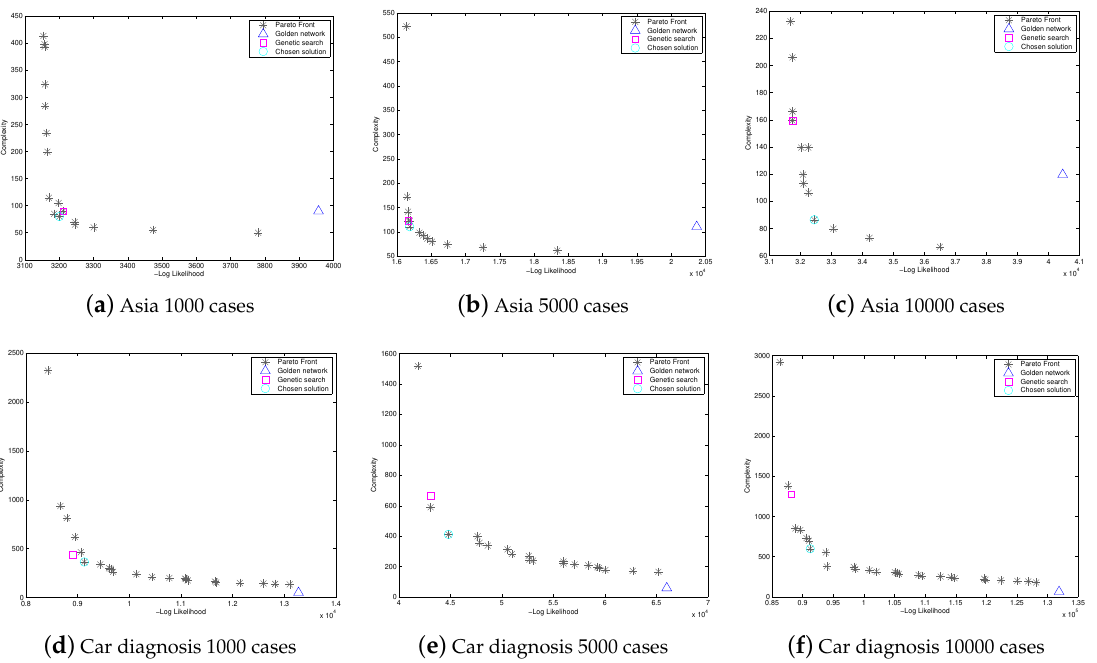
Figure 6. Accumulated Pareto front of the well-known benchmark databases with the different number of cases. Gray stars—the accumulated front obtained by ten runs of NS2BN. Blue triangle—the golden- standard network. Pink square—the GABN solution and the green circle—the chosen solution from the NS2BN Pareto front.